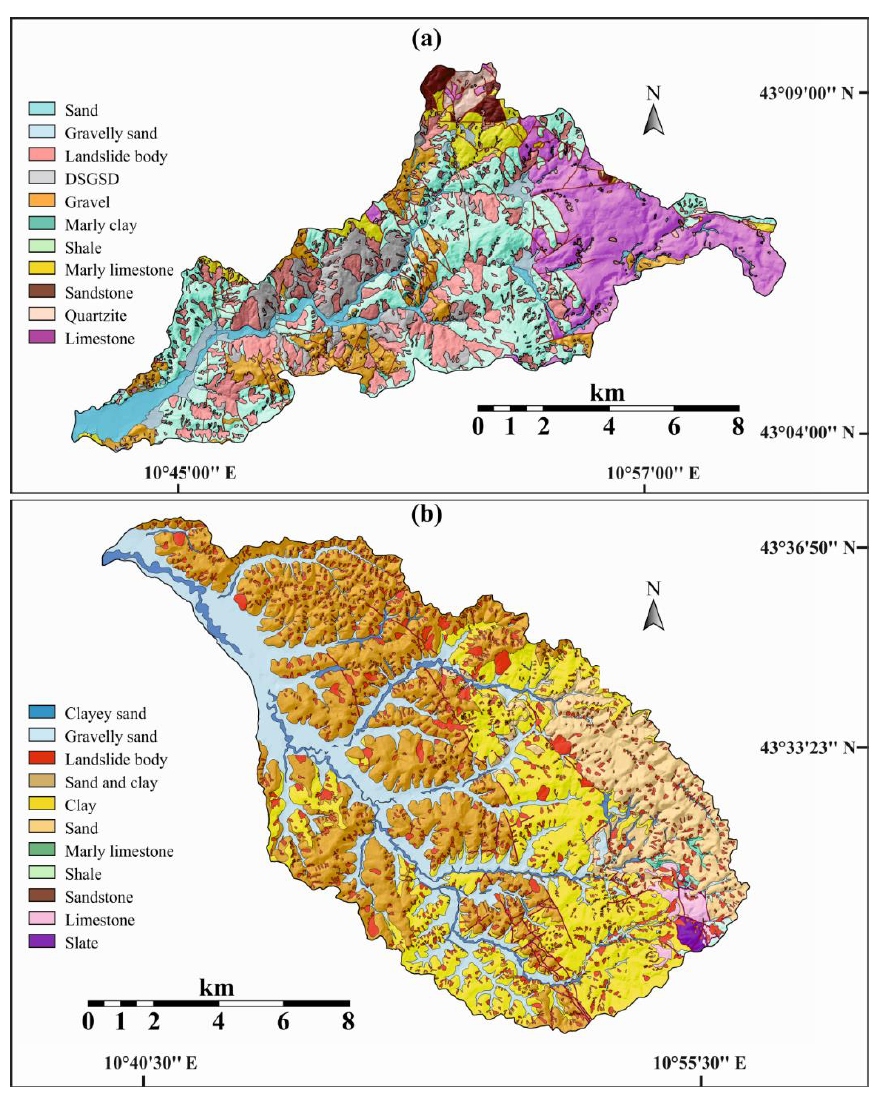
Figure 4. Lithological factor maps of the Milia ( a ) and Roglio ( b ) basins. Landslides are